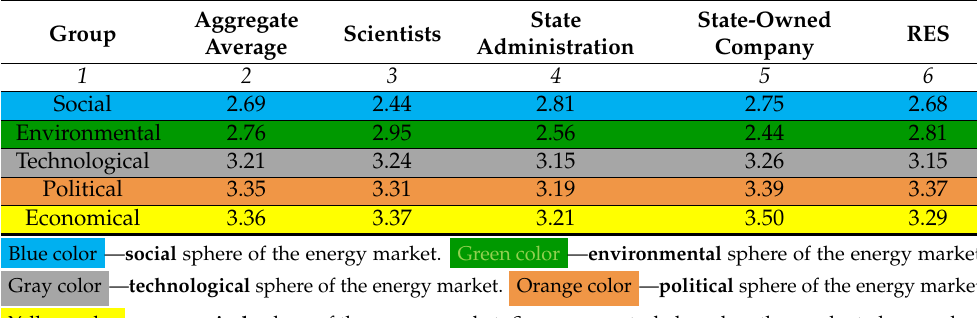
Blue color — social sphere of the energy market. Green color — environmental sphere of the energy market. Gray color — technological sphere of the energy market. Orange color — political sphere of the energy market. Yellow color — economical sphere of the energy market. Source : own study based on the conducted